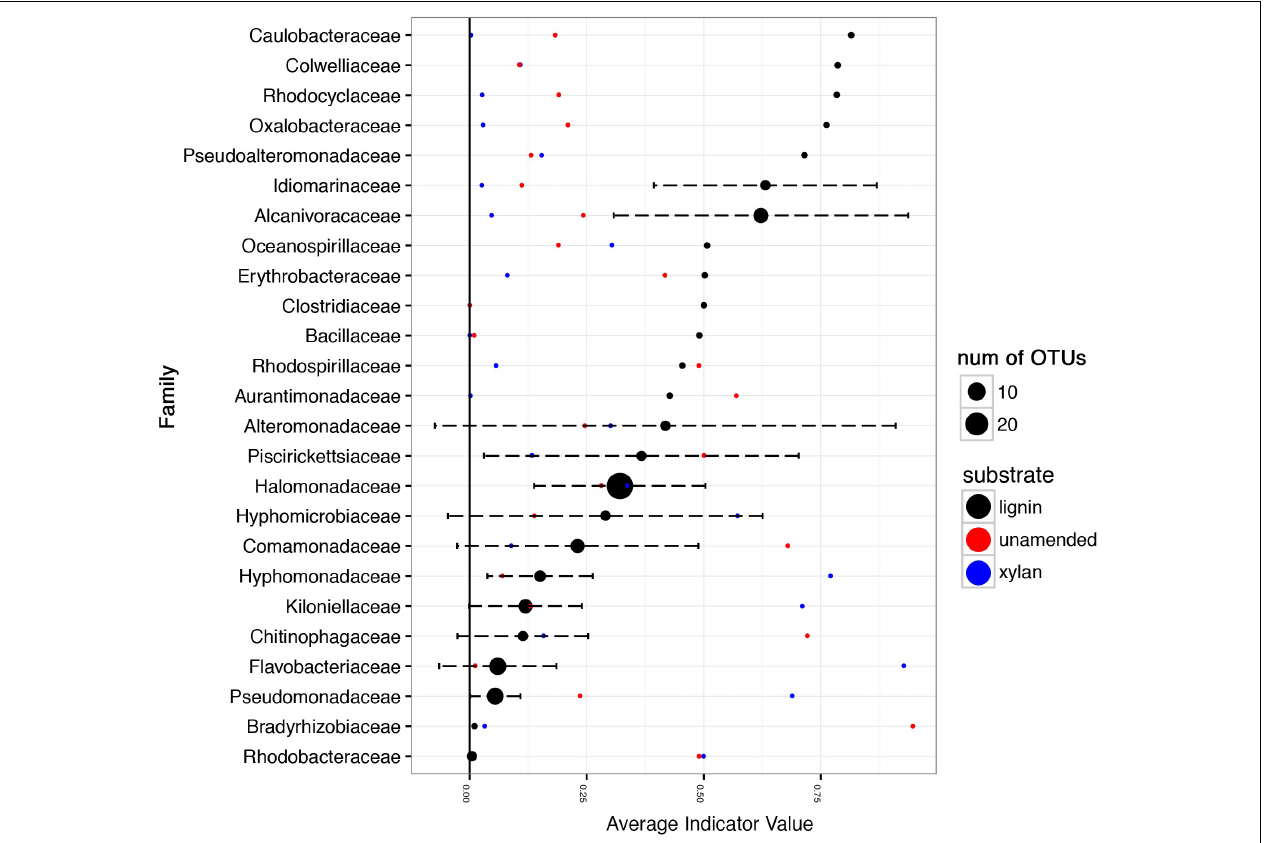
FIGURE 7 | Average indicator values of taxonomic families for lignin amendment. The abundances of the OTUs in the 16S rRNA gene amplicon data were used to calculate the indicator value using the R package labdsv indval function. The first and second incubations were combined for each substrate. The average of the indicator value for lignin is shown by the black points. The error bars indicate the standard deviation of the indicator values. The size of the point indicates how many distinct OTUs are represented in the dataset. Taxonomic families with indicator values less than 0.1 for lignin were excluded from the visualization. The red and blue points indicate indicator value for the unamended control and xylan amendment,